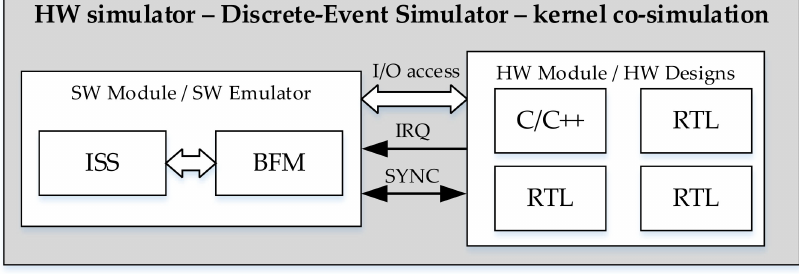
Figure 1. Block diagram of the general setup of Discrete Event Simulator (DES)-based HW/SW co-simulation virtual